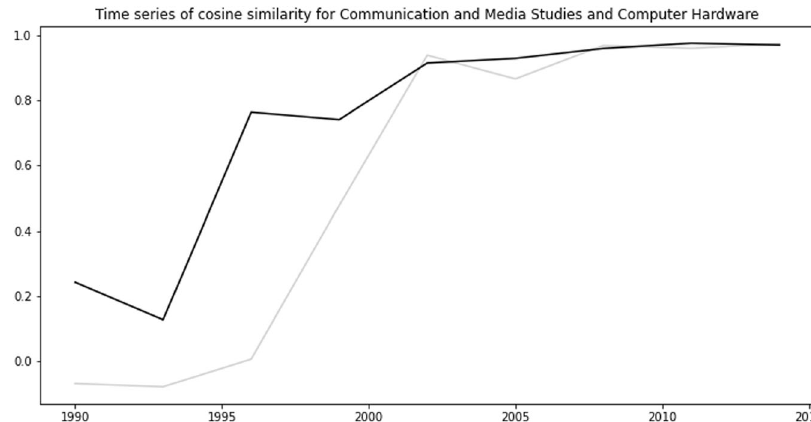
Fig. 4 Time series of the cosine similarity of the embeddings of two disciplines that changed pro fi le in the period under consideration. Communication and Media Studies (light grey) and Computer